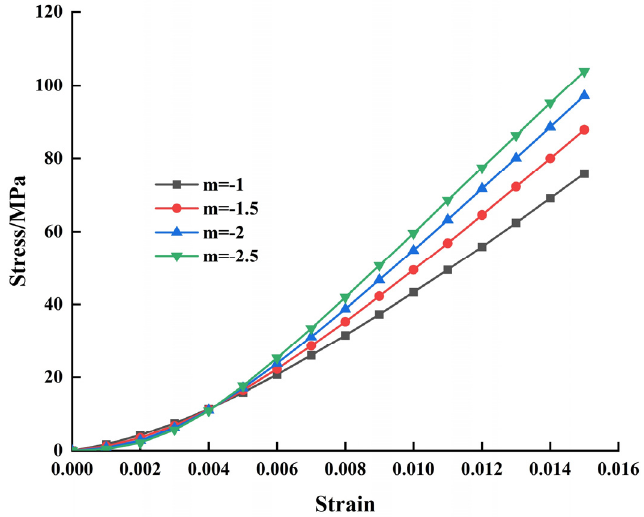
Figure 13. Parameter m study.